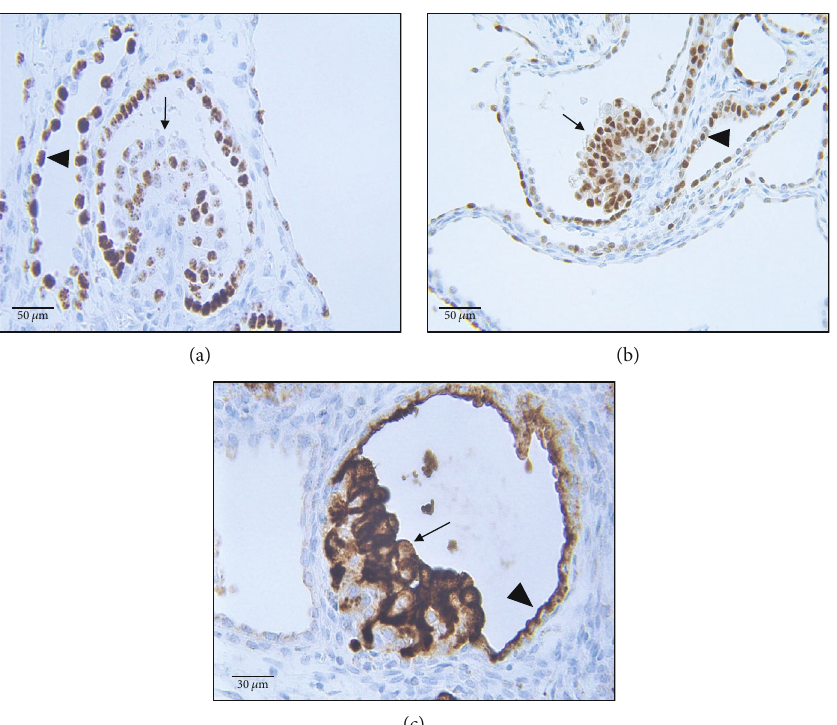
Figure 3: Expression of di ff erentiation markers Pax2, Pax8, und CD10 (immunohistochemistry). PAX2 (a) homogenous expression in the tubular epithelium (arrowhead) and to lesser extent in the epithelial proliferates/projections (arrow). PAX8 (b) expression features a homogenous pattern within tubular epithelium (arrowhead) and epithelial proliferates/projections (arrow). CD10 (c): strong expression of CD10 within epithelial proliferates (arrow) and weak expression in surrounding epithelial linings